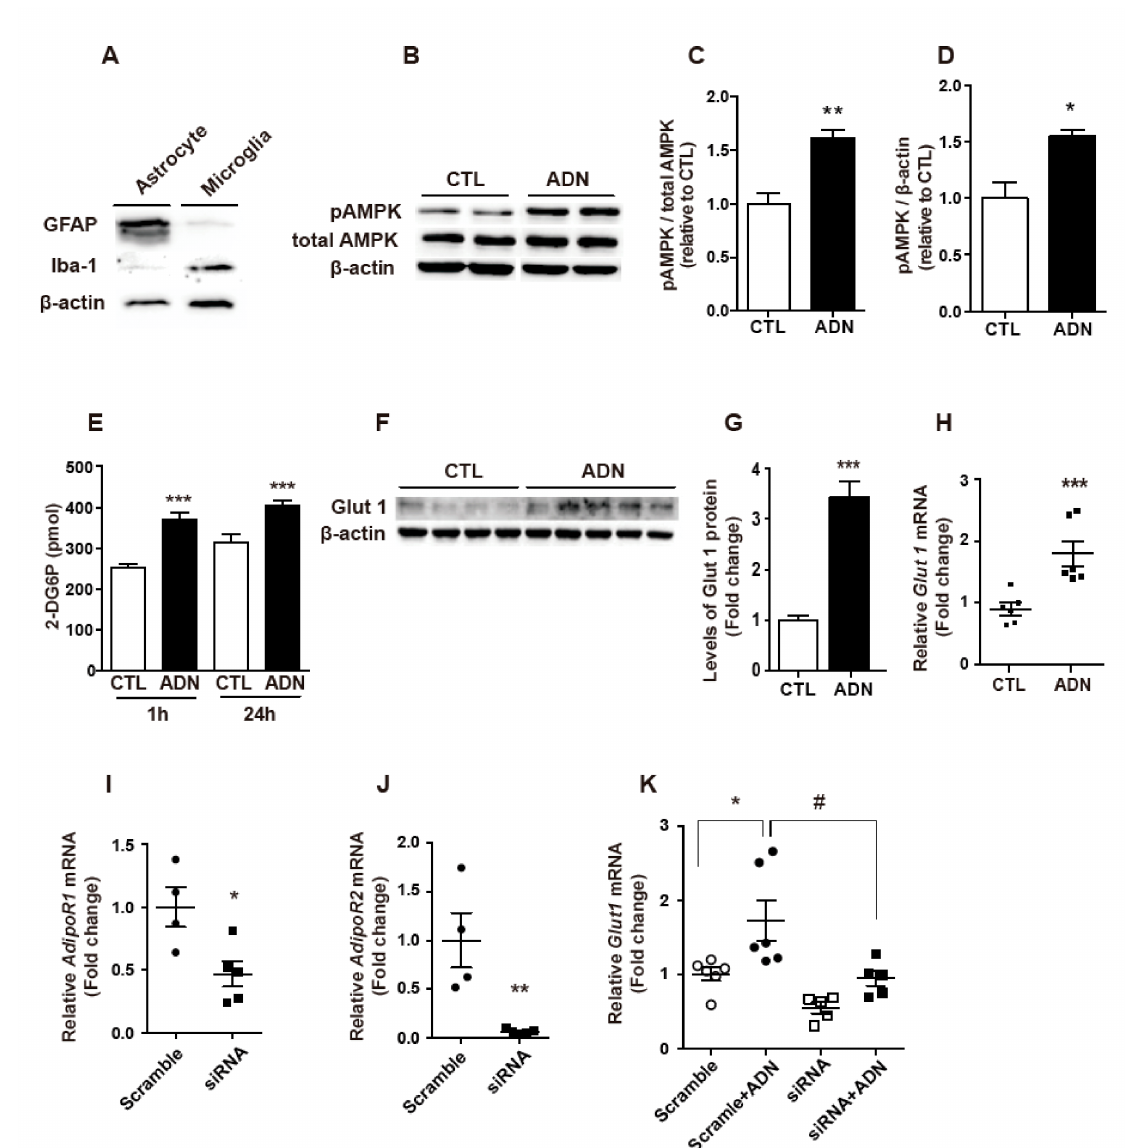
Figure 2. Adiponectin enhances glucose uptake in primary astrocytes. The primary astrocytes and microglia were set up at 5 × 10 5 cell/well and subjected to western blot analysis by using antibodies for GFAP and Iba-1 proteins. ( A ) GFAP protein was predominantly present in primary astrocytes but Iba-1 protein was almost absent in primary microglia. ( B – K ) Primary astrocytes were seeded at 5 × 10 5 cell/well, starved overnight, and treated with adiponectin (ADN, 1 µ g/mL) for 24 h. Cell lysates were subjected to western blot analysis using antibodies against ( B – D ) pAMPK, total AMPK, β -actin and ( F , G ) glucose transporter-1 (GLUT-1) proteins and qRT-PCR using a primer set of ( H , K ) Glut-1 gene. Exogenous treatment of adiponectin led to increased levels of ( F , G ) Glut-1 protein and ( H ) Glut-1 mRNA in primary astrocytes. ( E ) Adiponectin treatment enhanced glucose uptake in cultured primary astrocytes as determined by 2DG-glucose uptake assay. AdipoR1 and AdipoR2-specific siRNA were transfected into the primary astrocytes to confirm the mRNA expression of Glut1 induced by adiponectin treatment. qPCR data showed a significant decrease in ( I ) AdipoR1 and ( J ) AdipoR2 mRNAs. Elevated ( K ) Glut1 mRNA induced by adiponectin was effectively rescued by transfection of AdipoR1 and AdipoR2-specific siRNAs. Results are presented as the means ± SEM. n = 4 for ( B – D ); n = 3 for ( E ); n = 4–5 for ( F , G ); n = 6 for ( H ); n = 4–5 for ( I , J ); n = 5–6 for ( K ). All experiments were performed from at least three different preparations of astrocytes. * p < 0.05; ** p < 0.01; *** p < 0.001; # p <